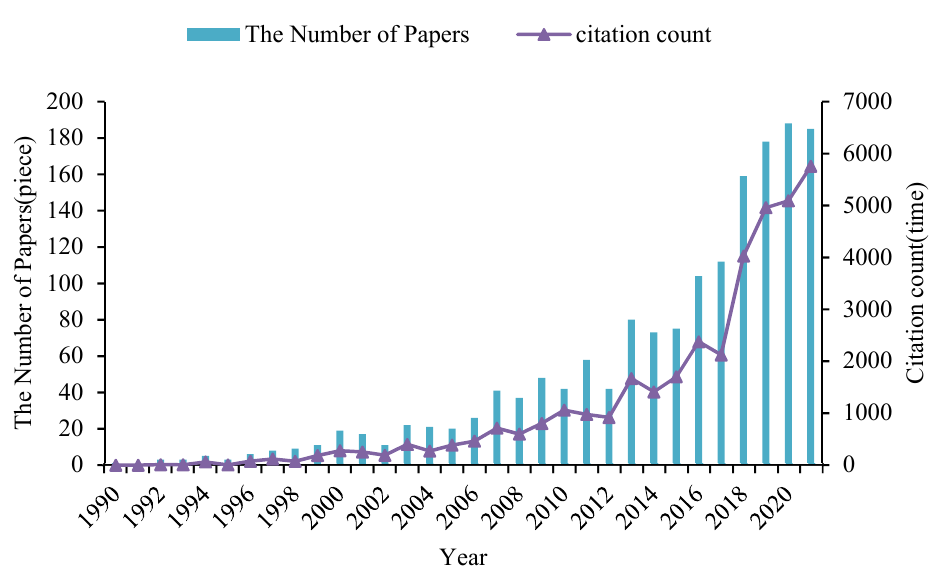
Figure 1. The number and citation count of literature on performance management of natural resources from 1990 to 2021.